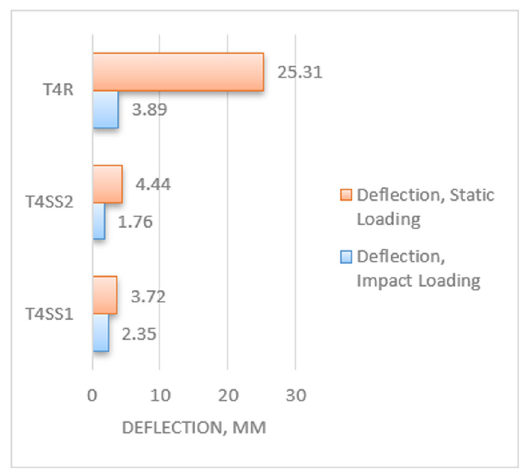
Figure 17: Impact and static loading capacity of the slabs.